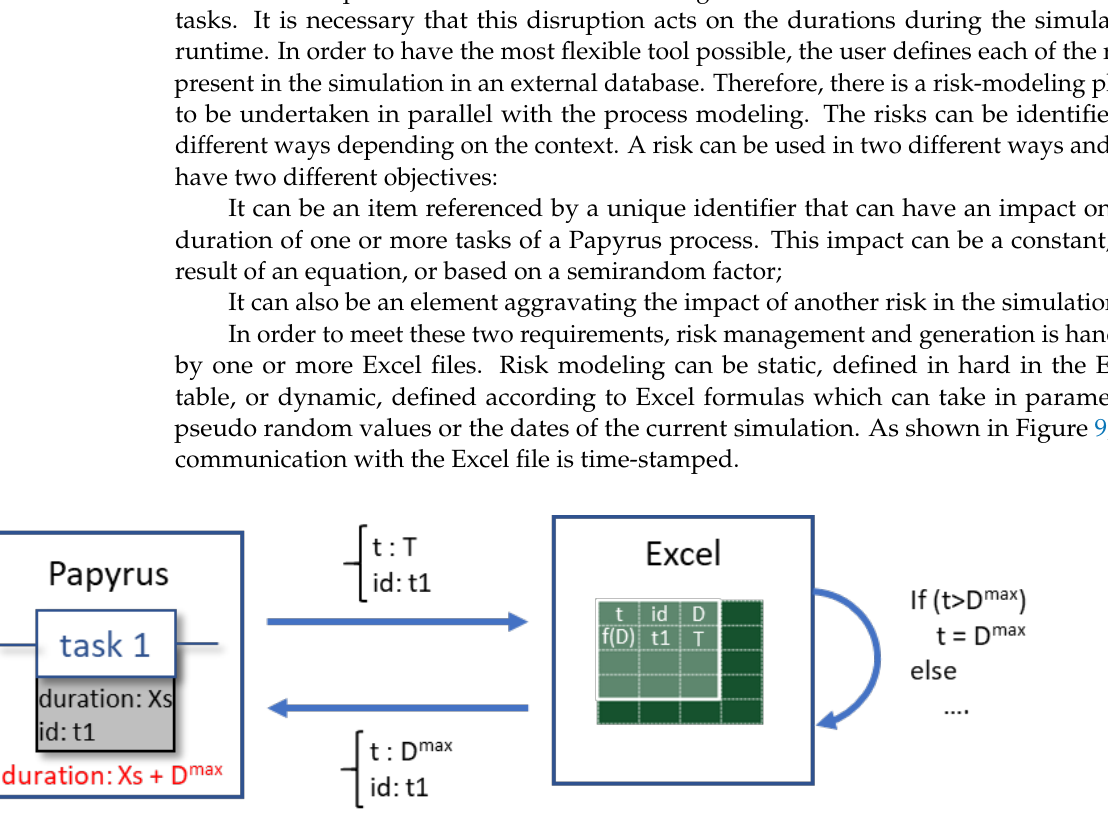
Figure 10. Task life duration from UML Profile. The getDuration() method returns a double representing a duration in nanoseconds. Therefore, the sum of the durations of the advices represents the total time of the task (t) as the following equation: